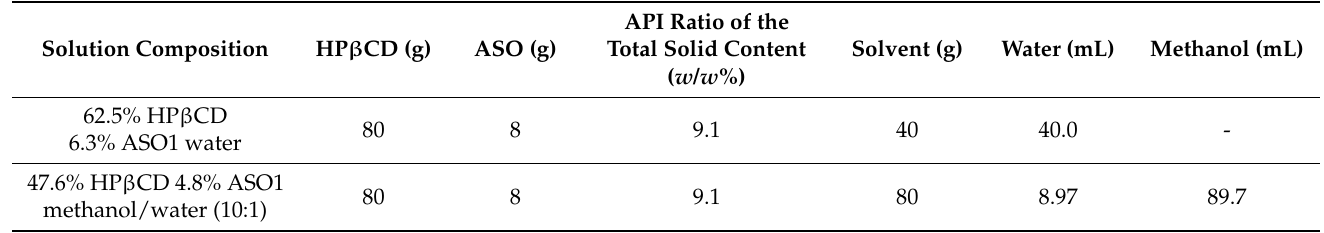
Table A1. Composition of solutions used for electrospinning. The methanol density (0.792 g/cm 3 ) was used for the calculations.